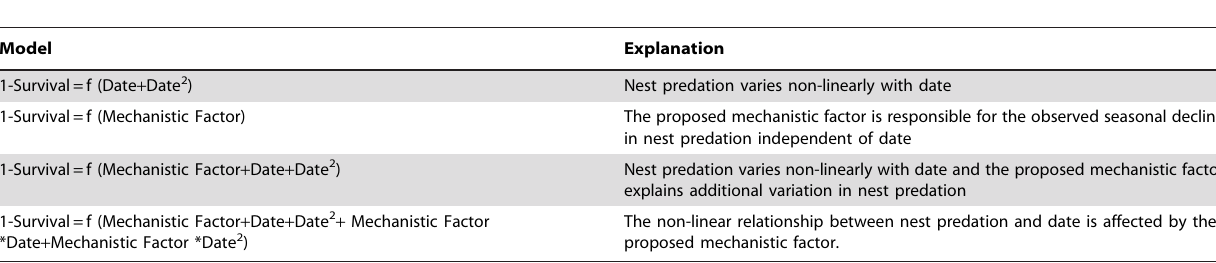
Table 1. Explanation of the models used to examine proposed mechanisms that could affect seasonal changes in the risk of nest predation.